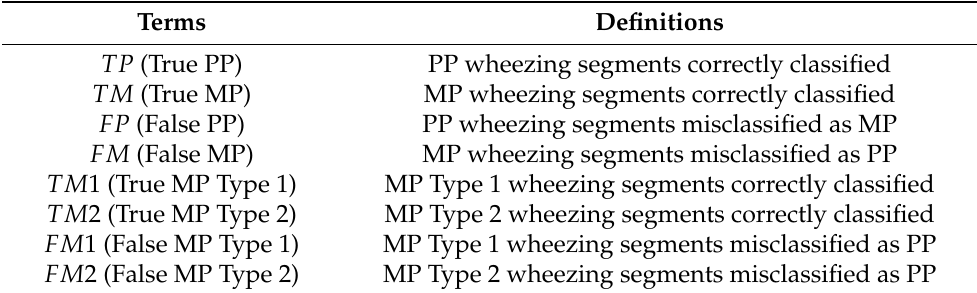
Table 1. Definition of the terms that appear in the metrics detailed in Equations (22)–(26).